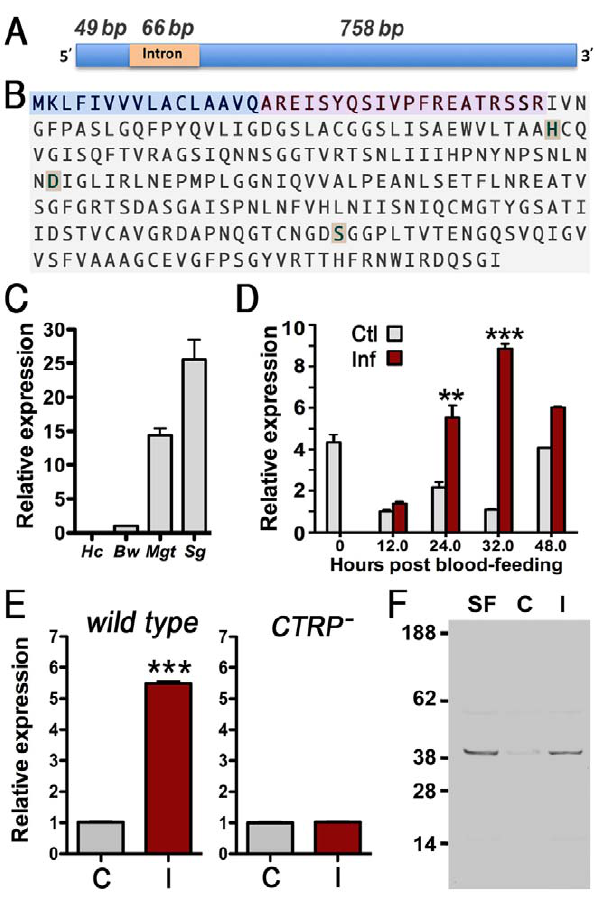
Figure 1. AgESP gene structure and expression. (A) Diagram of AgESP cDNA with exons shown in blue and the intron in orange. The size of each region is indicated in base pairs (bp). (B) Deduced amino acid sequence of AgESP protein showing the predicted signal peptide (light blue), the pro-peptide (pink), and the amino acids comprising the catalytic triad (H, D, and S; in beige). (C) Tissue-specific expression of AgESP mRNA in hemocytes (Hc), body wall (Bw), midgut (Mg), and salivary glands (Sg) of 5-day-old adult females. (D) AgESP mRNA levels in midguts of female mosquitoes fed on a healthy mouse (Ctl, control; grey bars) and Plasmodium berghei -infected (Inf; red bars) at different times post feeding (PF). (E) AgESP mRNA levels in midguts of mosquitoes fed on a healthy mouse (Ctl, control; grey bars) or infected with P. berghei (I, infected; red bars) ANKA 2.34 wild-type and CTRP – knockout parasites 24 h PF. The unpaired two-tailed t -test was used to compare the different experimental groups (*, P , 0.05; **, P , 0.01; ***, P , 0.001). (F) AgESP protein expression in midguts from sugar-fed (SF) females or 24 h after feeding on healthy (C, control) or P. berghei - infected (I) blood. All expression analysis was confirmed in 2–3 independent biological replicates.